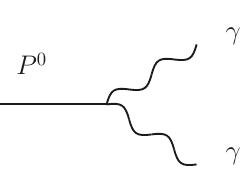
Figure 1 . Local contribution to the P 0 ! (cid:13)(cid:13) decay.